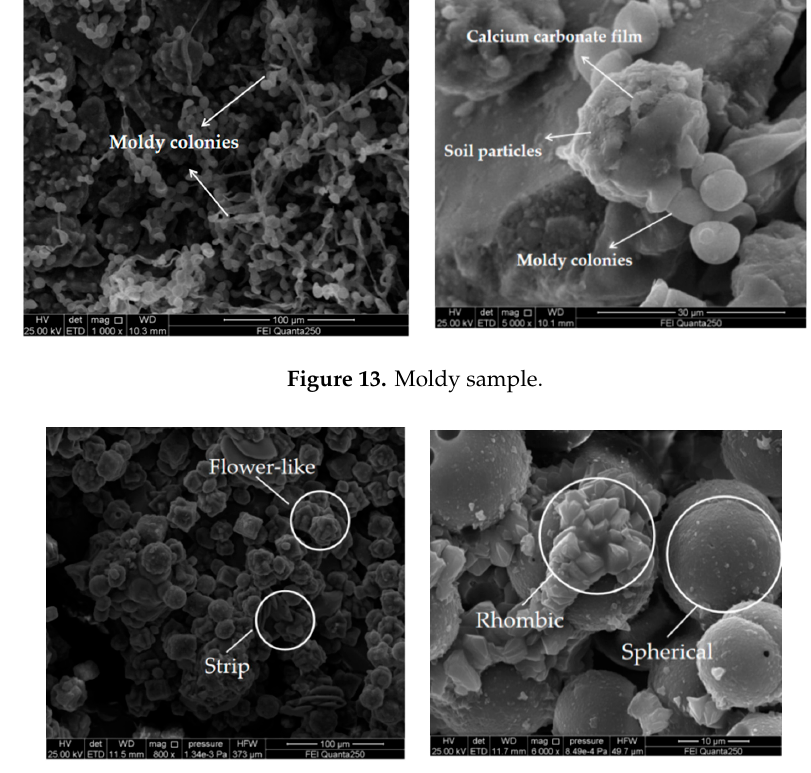
Figure 14. Crystal morphology of calcium carbonate in subsequent